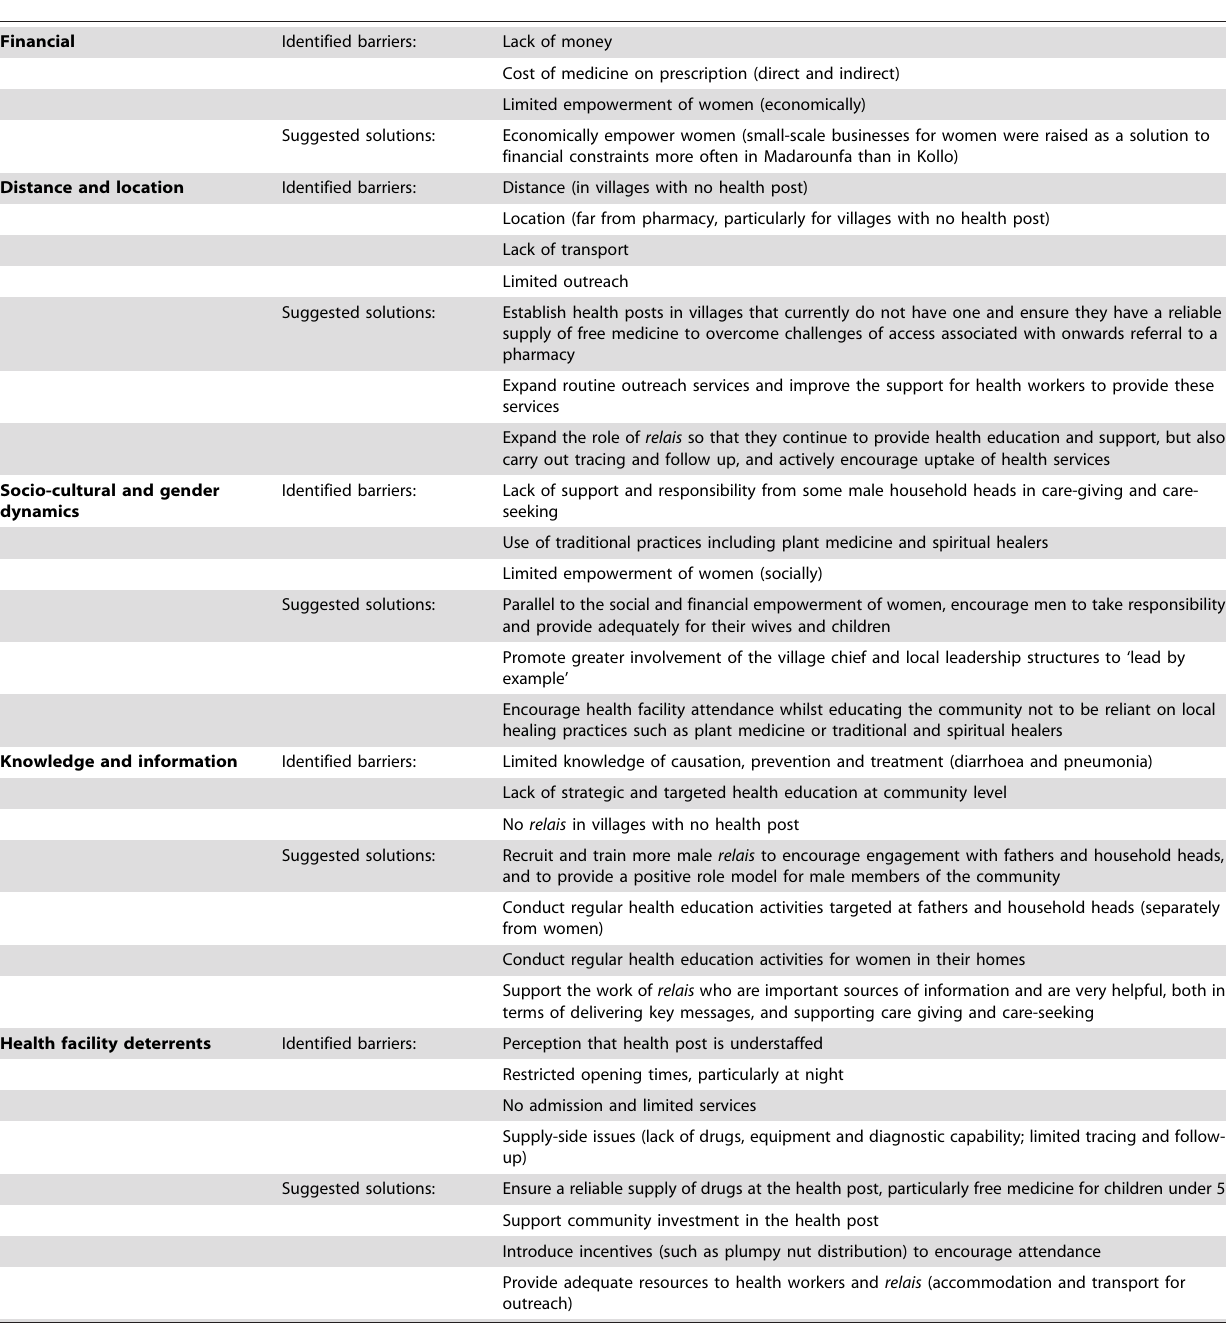
Table 5. Barriers and related solutions identified by caregivers in